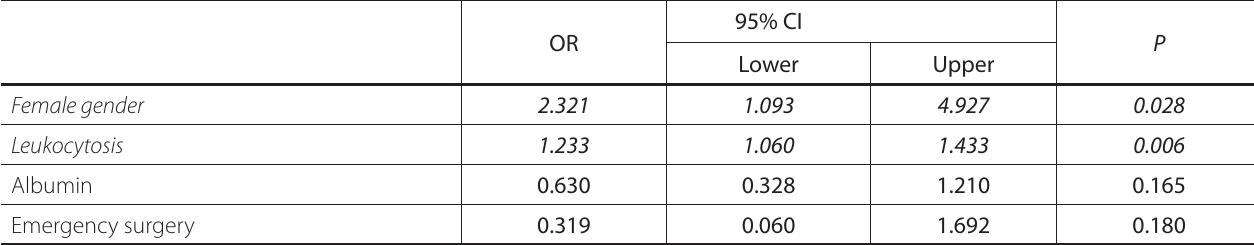
Table 5. Logistic regression analysis – perioperative factors.